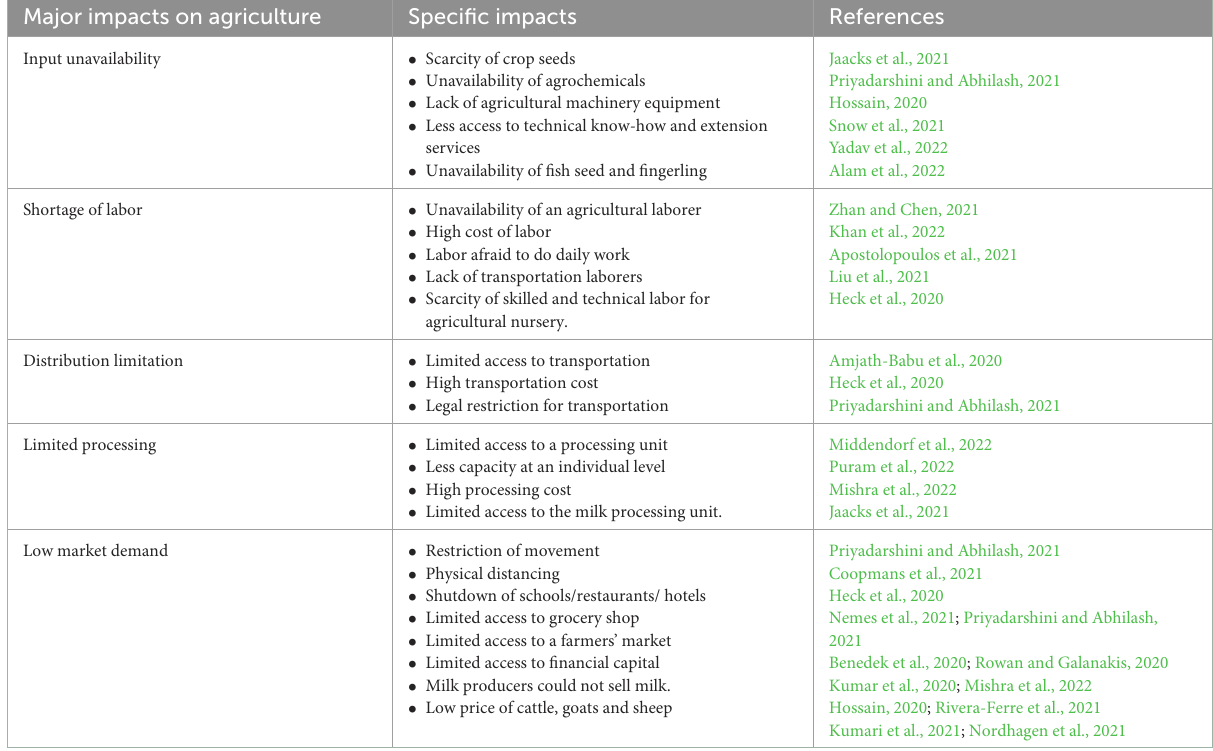
TABLE 2 COVID-19’s impact on agricultural